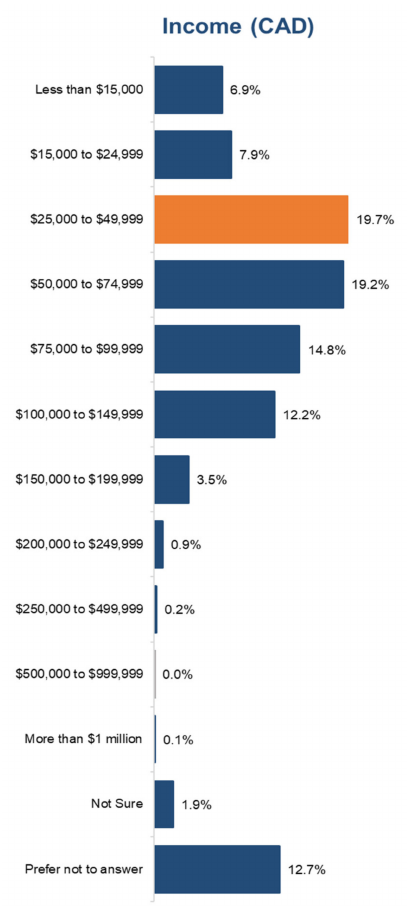
Figure 1. Respondents based on